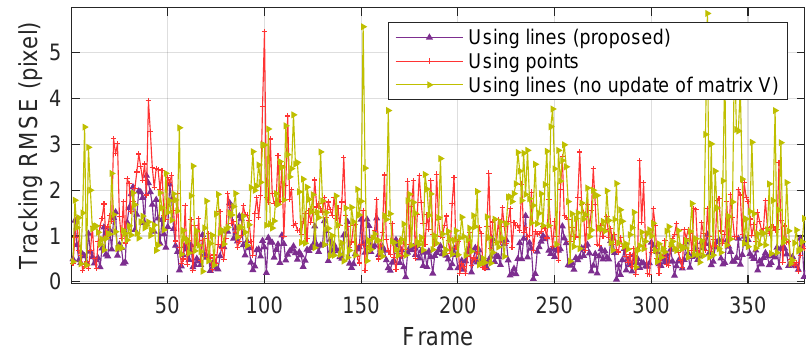
Figure 17. Tracking RMSE for each